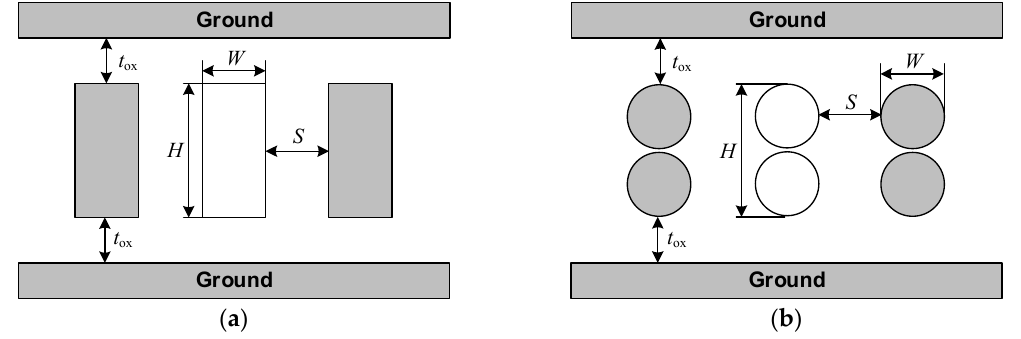
Figure 3. Cross-sectional views of ( a ) Cu and ( b ) MWCNT interconnect configurations in an advanced integrated circuit design. Table 1. Geometrical and physical parameters at the 14 nm and 7 nm technology nodes. Technology Node